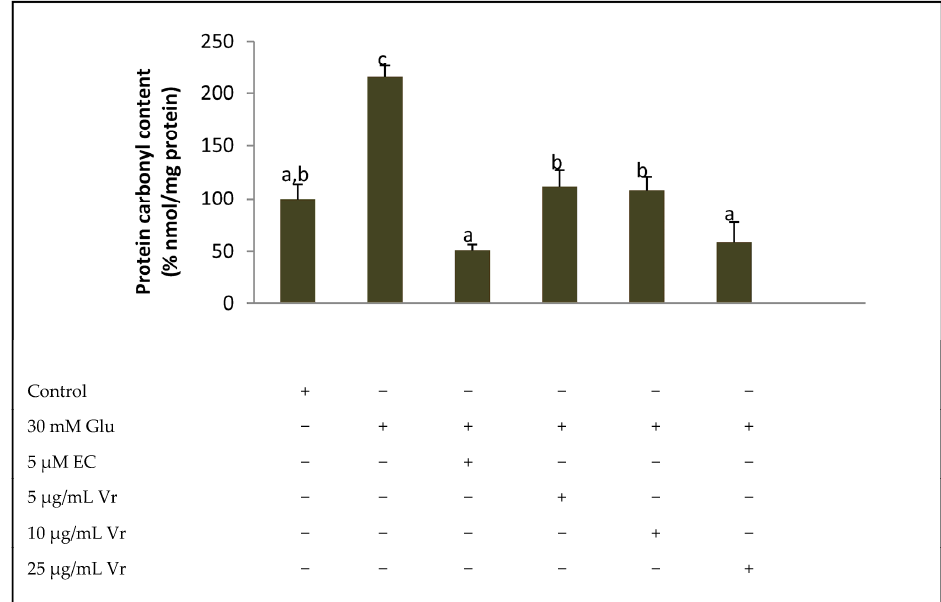
Figure 3. Protective effect of Vochysia rufa bark treatment on carbonyl group production by EA.hy926 cells. Content of carbonyl groups was evaluated in EA.hy926 cells treated with 30 mM glucose (Glu 30 mM) or 30 mM glucose plus noted concentrations of Vochysia rufa (Vr) extract or the positive control epicatechin (EC). Values are means ± SD, n = 3. Values are expressed as a percent relative to control condition. Different letters indicate statistically significant differences ( p < 0.05) among groups.